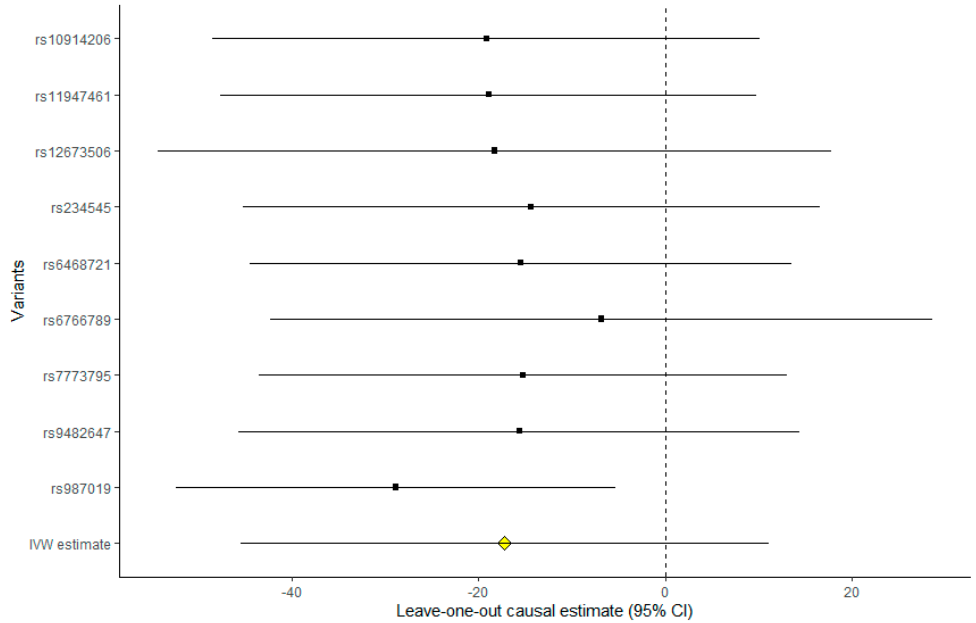
Figure 3. Leave-one-out sensitivity analysis for the association using the nine SNPs. Each point and error line represents the MR analysis (using IVW) excluding that particular SNP. The overall analysis including all SNPs is also shown for comparison. SNPs: Single nucleotide polymorphisms.